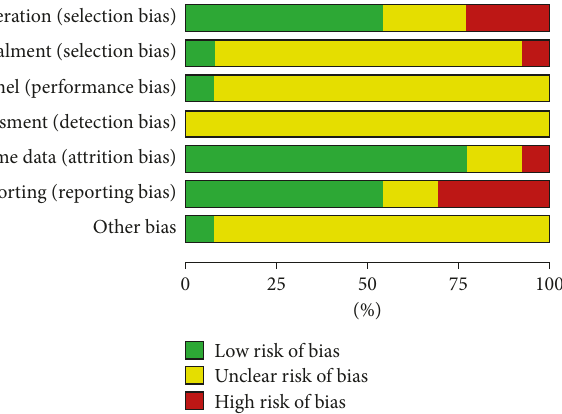
Figure 2: Risk of bias graph. (MD = − 5.07, 95% CI: − 9.12, − 1.01, P = 0.01); 4 studies [10, 11, 16, 21] compared the change in Scr after 6 months of the treatment. Results indicated heterogeneity among groups ( P = 0.0009, I 2 = 74%). Random effect model analysis found that treatments improved Scr (MD = − 6.92, 95% CI: − 10.73, − 3.10, P = 0.02). Subgroup analysis was performed on Scr in the monthly group. There was statistical heterogeneity among the study groups ( P < 0.00001, I 2 = 79%). Random effect model analysis found no difference in Scr (MD = − 6.92, 95% CI: − 10.73, − 3.10, P = 0.3) as shown in Figure 8. 3.7. AE. Among the included studies, 5 studies did not mention the occurrence of AE, and AEs were reported in the other 8 studies (Table 3), all of which described that the AEs were relieved and controlled after effective treatment, and there were no withdrawals due to AE. We compared the incidence of AE among the 8 included studies, of which 4 studies [12, 13, 17, 18] compared the incidence of AE after 3 months of treatment and found little heterogeneity ( P = 0.20, I 2 = 35%); fixed-effect model analysis revealed a significant difference in AE incidence between the groups (OR = 2.01, 95% CI: 0.79, 5.11, P = 0.14). 4 studies [10, 11, 15, 22] compared the occurrence of AE after 6 months of treatment, and there was little statistical heterogeneity among the groups( P = 0.48, I 2 = 0%); the fixed-effect model analysis revealed that 6-month treatment drastically in- creased AE (OR = 2.31, 95% CI: 1.15, 4.66, P = 0.02). The subgroup analysis of AE in the 3-month and 6-month treatment groups showed very little heterogeneity ( P = 0.48, I 2 = 0%), and the fixed-effect model analysis revealed no difference in AE (OR = 2.20, 95% CI: 1.26, 3.85, P = 0.82) (Figure 9). Figure 3: Risk of bias summary. “+” low risk of bias, “ − ” high risk 3.8. Publication Bias Assessment. Taking the TR as an ex- of bias, and “?” unclear risk of ample, a funnel plot was drawn to detect whether there was a small sample size publication bias. The results indicated that the studies were basically distributed on two sides of the funnel plot line. It can be clearly observed that the included literature has a certain degree of skewed distribution. The risk of publication bias is low (Figure 10).